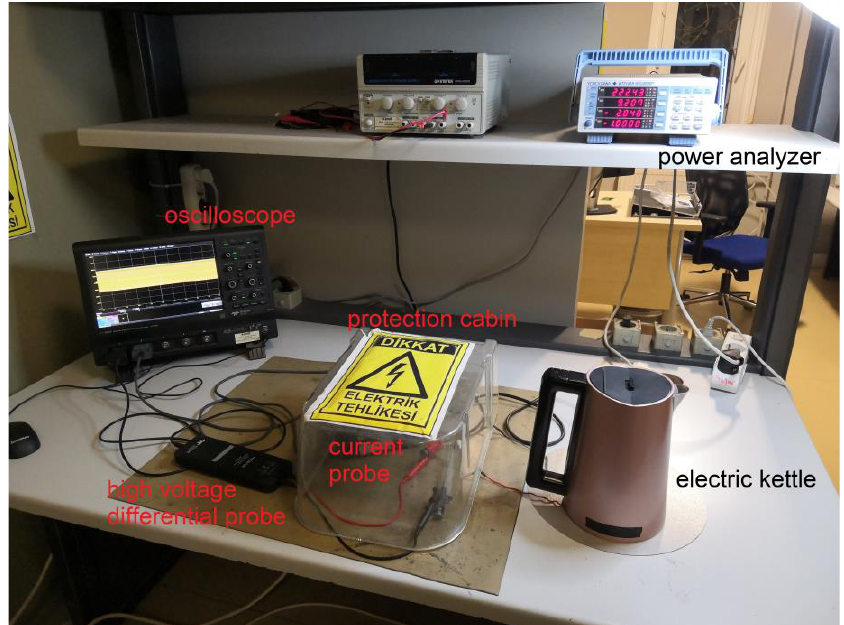
Figure 15. Test setup for direct connection of electric kettle to the mains.